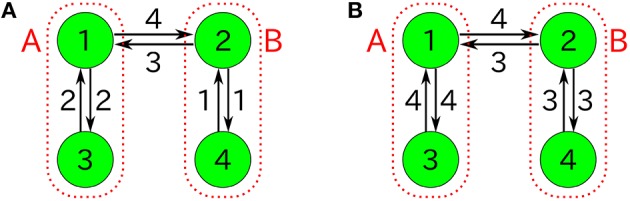
Four-component non-autocatalytic reactions duplicating behaviors of the 2TK model; (A) R123 = R142 = R214 = R231 = R321 = R412 = 1 (others 0), and (B) R142 = R143 = R231 = R234 = R341 = R432 = 1 (others 0). If one regards the species 1 and 3 as the species A (similarly, 2 and 4 as B), the behavior of nA = n1+n3 and nB = n2+n4 is almost equivalent to that of the 2TK model.